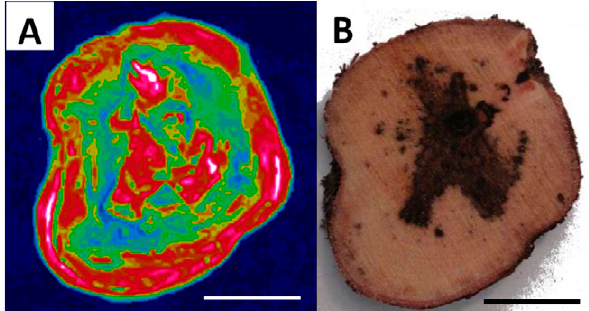
Figure 2. Magnetic resonance image (A) and the corresponding original photograph (B) of a grapevine trunk (cv. Castelão). Scale bars = 1